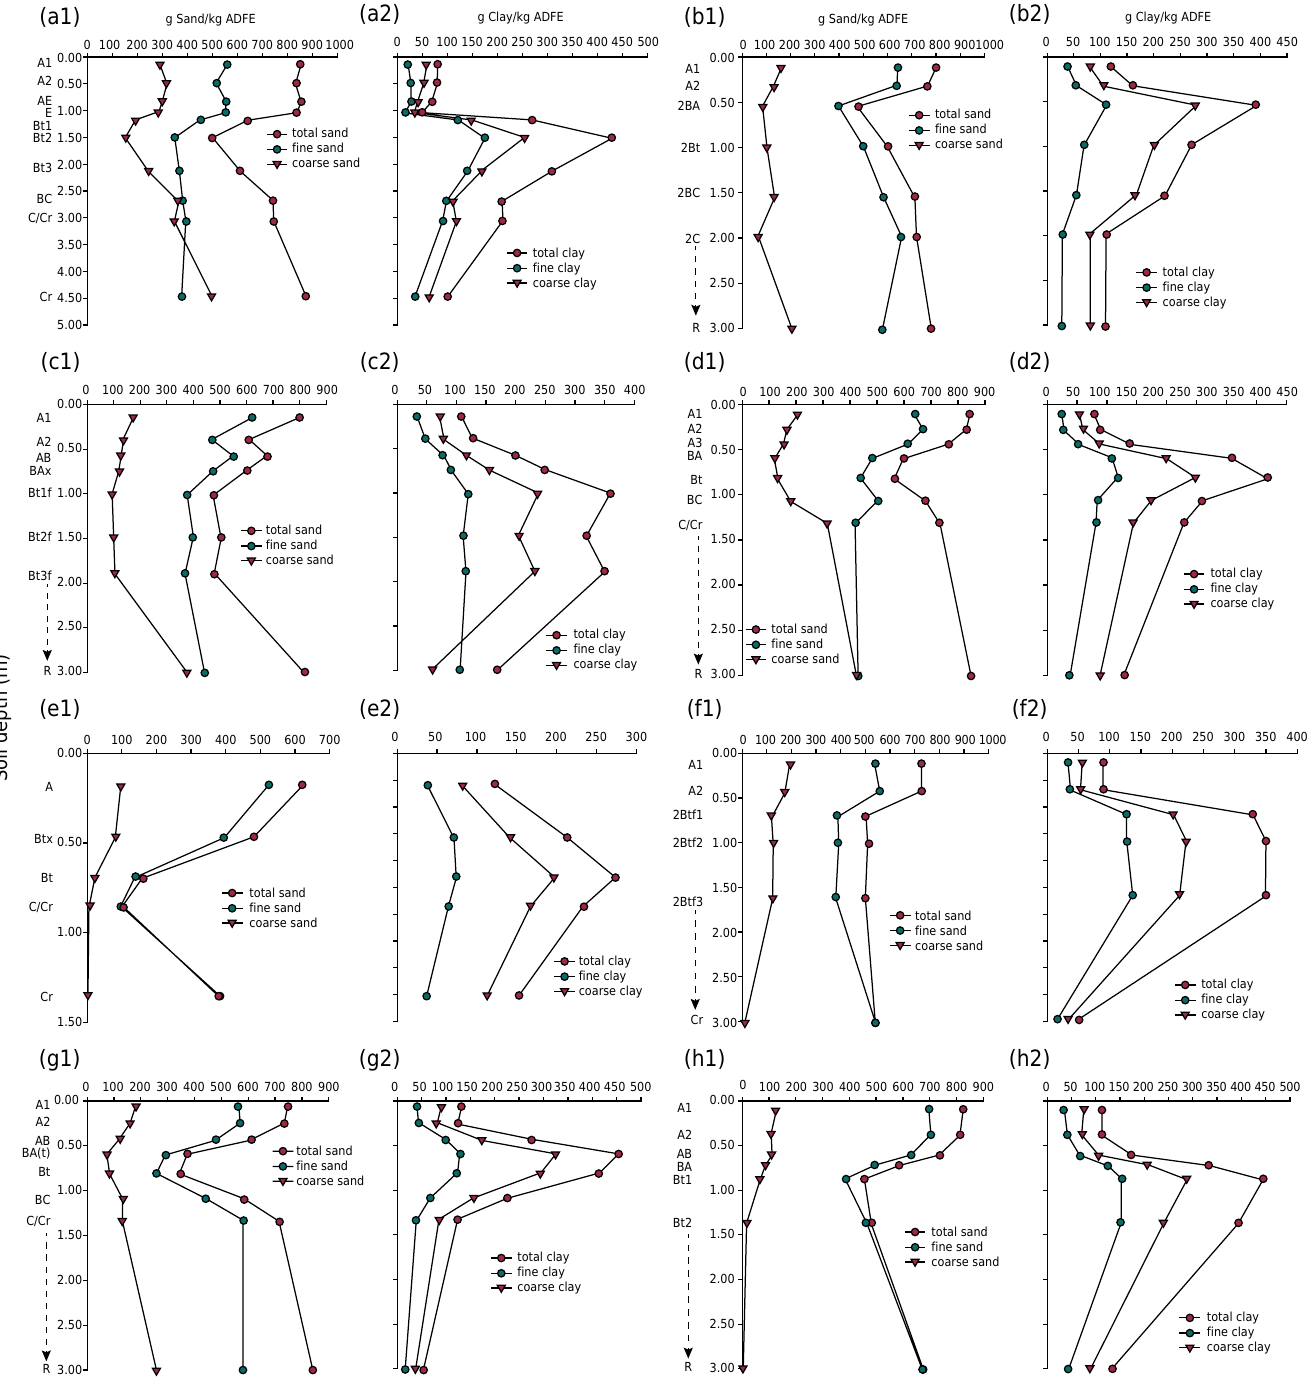
Figure 4. Distribution of soil granulometric fractions according to the depth of horizons and layers in the studied soil profiles: (a1 and a2) P1T1; (b1 and b2) P2T1; (c1 and c2) P3T1; (d1 and d2) P1T2; (e1 and e2) P2T2; (f1 and f2) P3T2; (g1 and g2) P1T4; (h1 and h2)